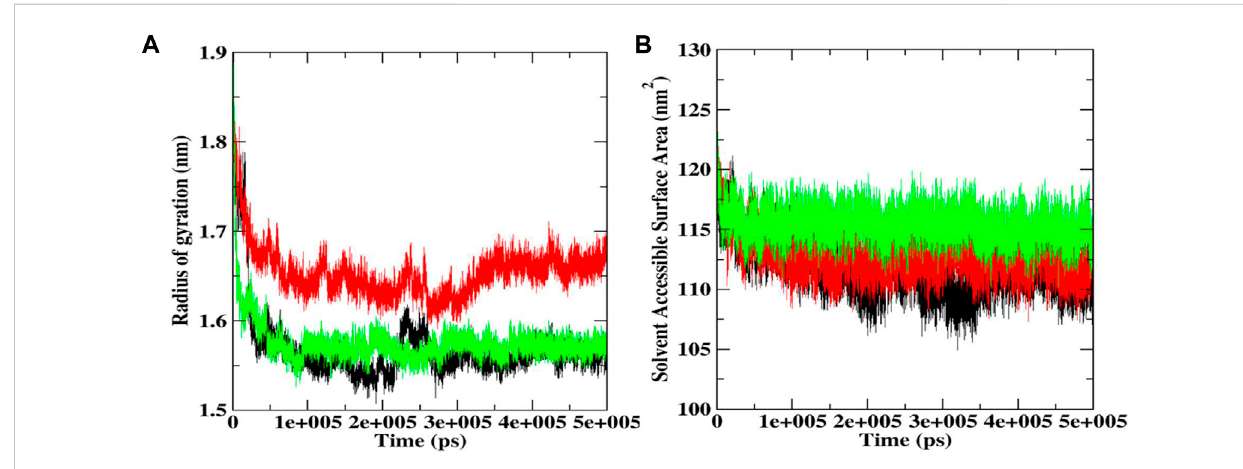
FIGURE 8 Rg (A) and SASA plot (B) during 500 ns MD simulations docked complexes of native Bcl-2, and complexes with procyanidin B2 and luteolin-7- O